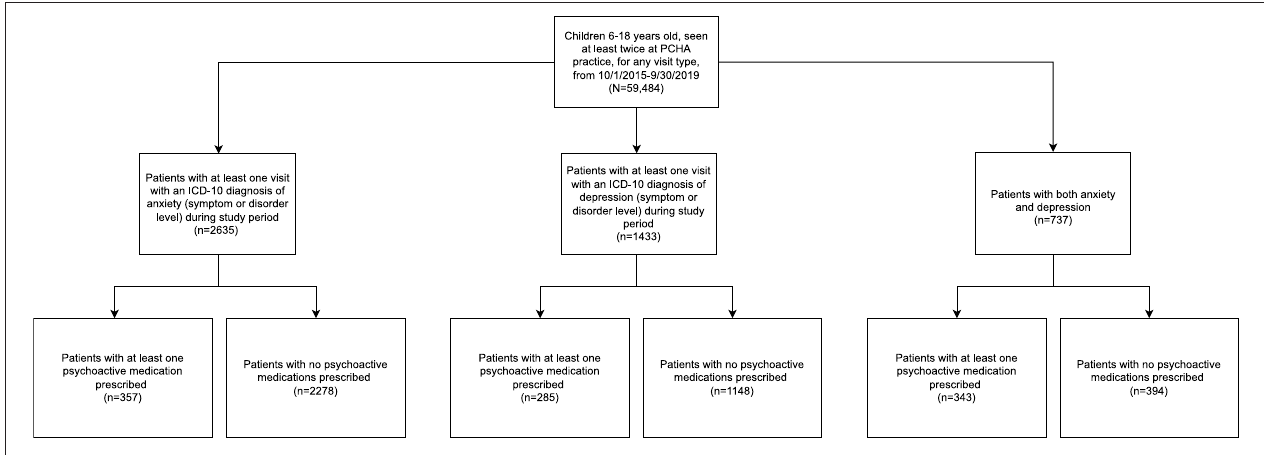
FIGURE 1 | Cohort